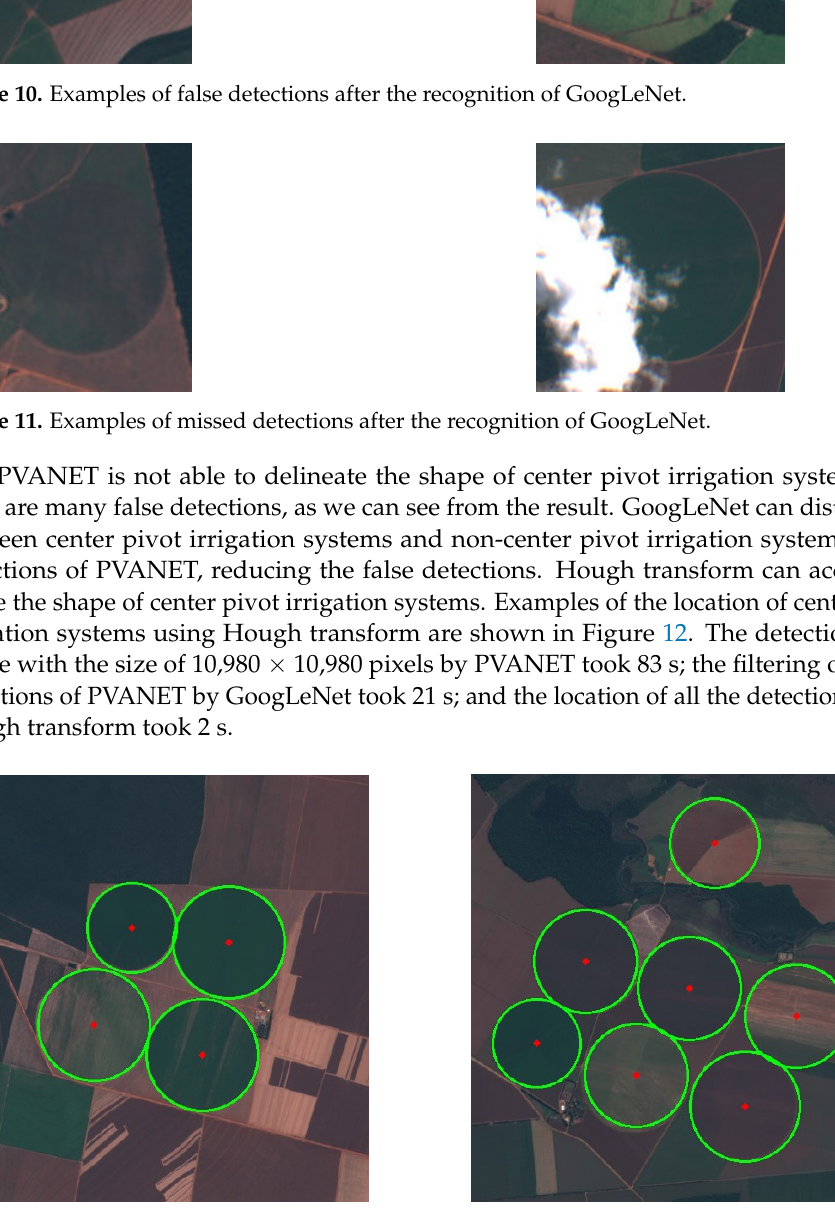
Figure 12. Examples of the location of center pivot irrigation systems using Hough